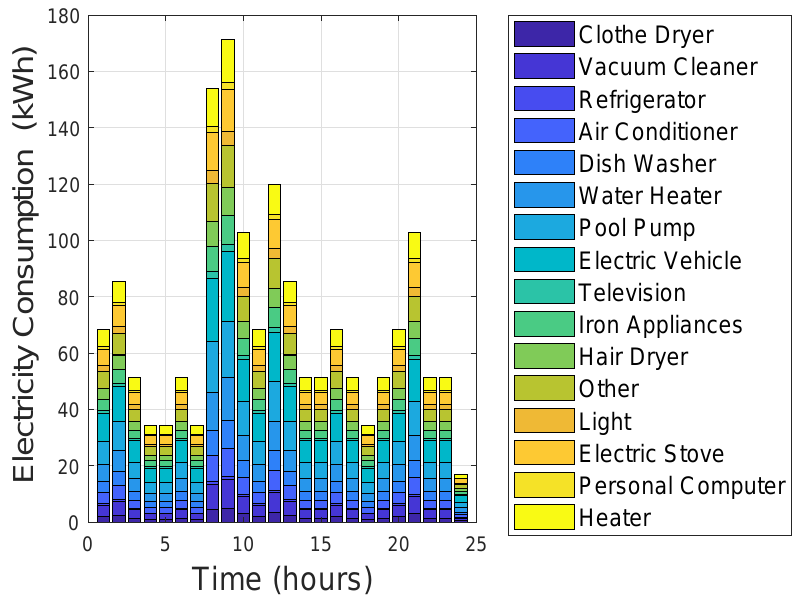
Figure 7. Hourly electricity consumption for each appliance without